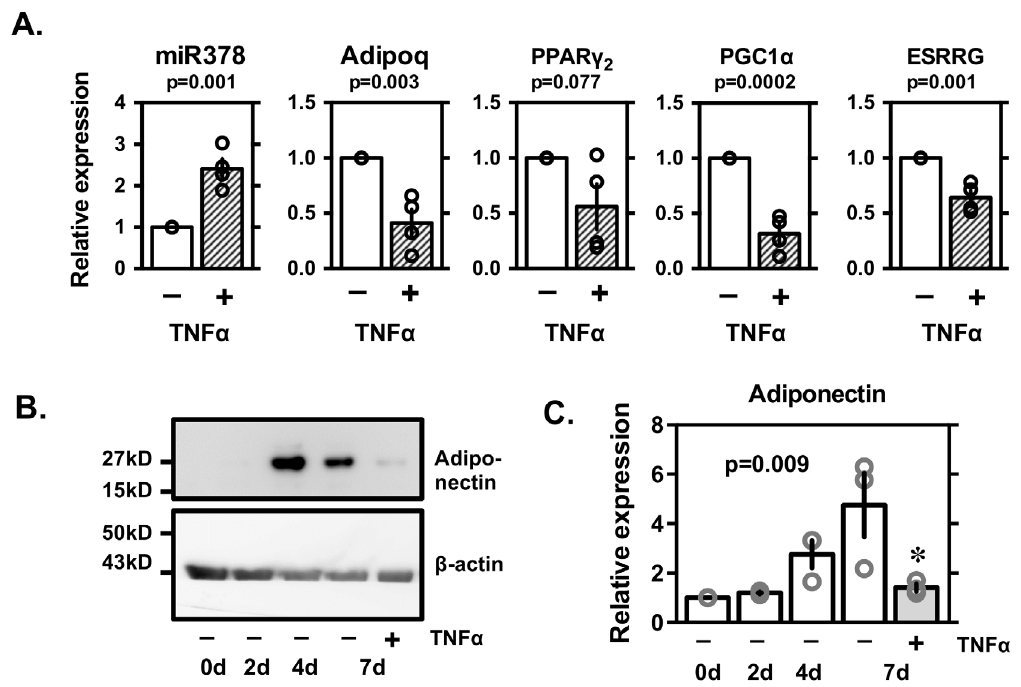
Figure 5. Level of miRNA 378 and mRNA levels of adiponectin, PPAR c 2 , PGC1 a and ESRRG (A), representative blot (B) and average expression levels of adiponectin protein with or without TNF a in 3T3L1 adipocytes (C). 3T3L1 adipocytes were treated with human recombinant TNF a (10 m g/mL, R&D systems) on day 6 and miR-378 and mRNA levels were evaluated by qRT-PCR or Western blotting on day 7. Expression levels normalized to those of b -actin. Individual values are shown with mean 6 SE (n=4). p values are shown for intergroup comparison by non-parametric Kruskal-Wallis test. *p , 0.05 vs . controls or 0 for unpaired two group comparison by Wilcoxon-Mann-Whitney test.